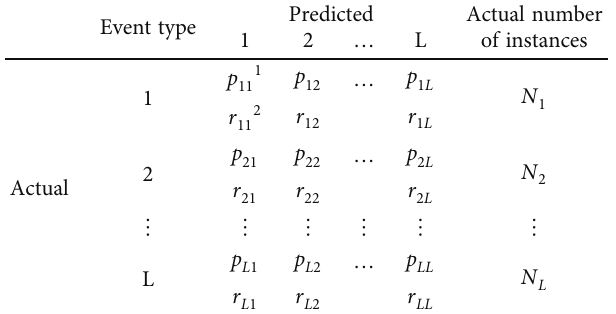
Table 6: Confusion matrix of an event type detection method. Event type